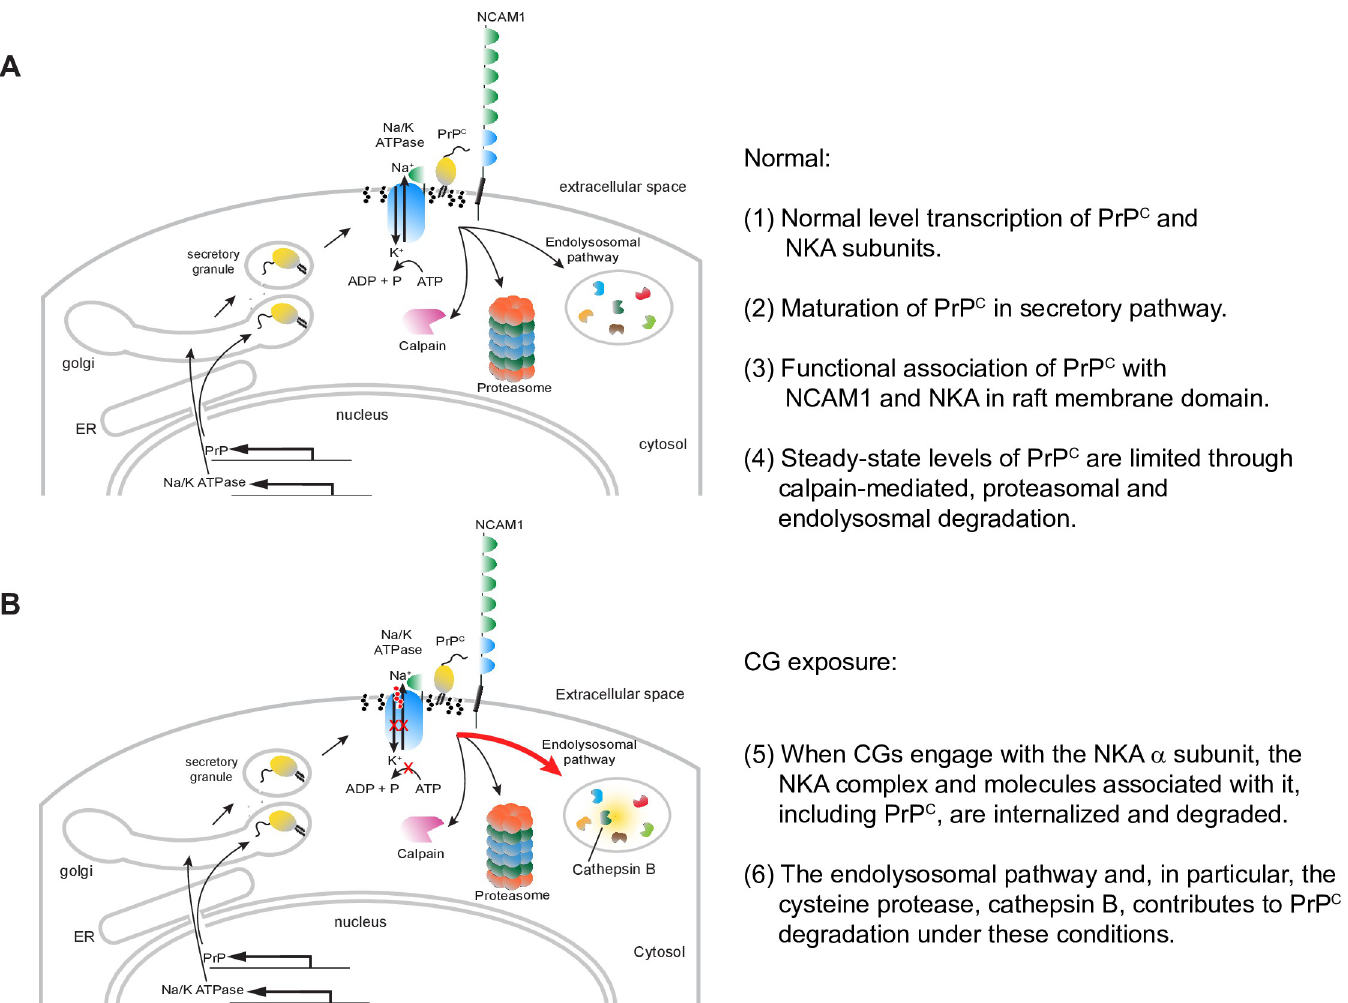
Fig 7. Model of CG-dependent reduction of PrP C . (A) Normal cell homeostasis. (B) Enhanced lysosomal degradation of PrP C upon exposure to non-toxic levels of CGs.